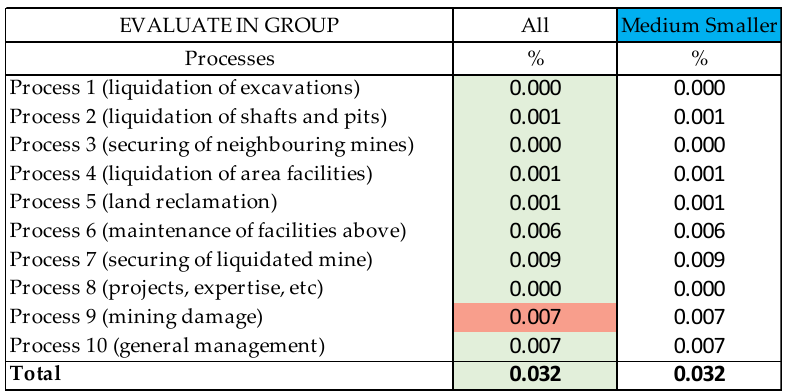
Figure 7. Assessment of the hypothetical branch B20 with average values of the liquidation cost of Medium Smaller Branches (MSB).